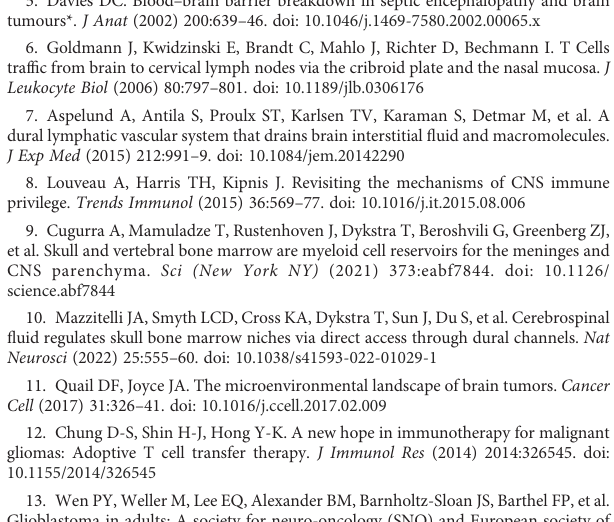
SUPPLEMENTARY FIGURE 8 GL261-CIITA tumors are highly in fi ltrated by T cells up to 42 days after tumor cellsinjection. C57BL/6micereceived intracranial injectionof3x10 4 GL261or GL261-CIITA glioma cells. At day 21 from injection, mice were sacri fi ced,